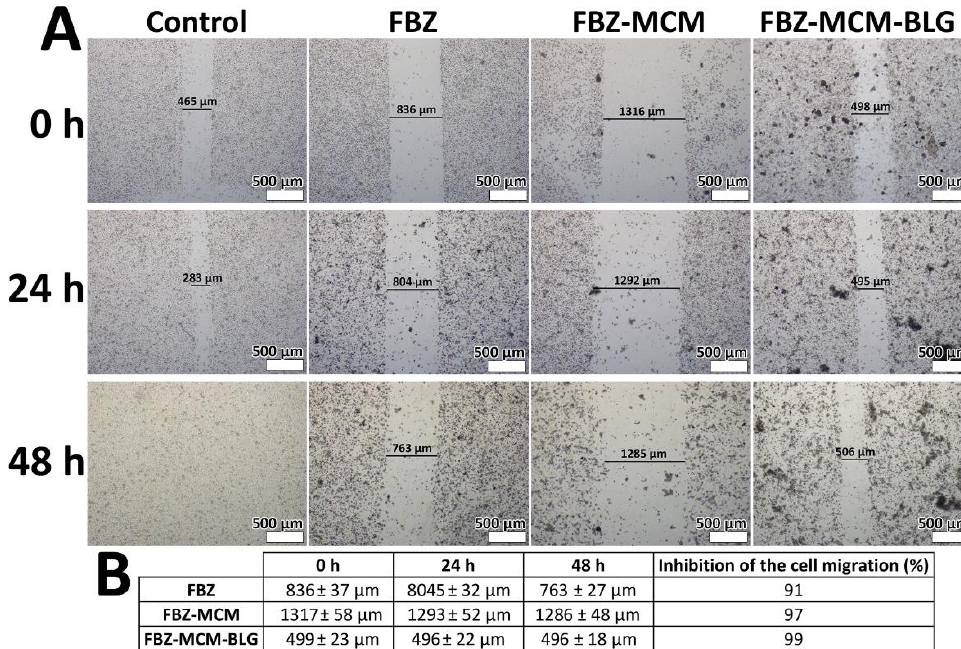
Figure 7. ( A , B ) Effects of FBZ, FBZ-MCM, and FBZ-MCM-BLG nanoparticles on the migration and invasion of prostate cancer PC-3 cells before (0 h), 24 h after, and 48 h after cell treatment (×40 mag). Compared to the control group, FBZ, FBZ-MCM, and FBZ-MCM-BLG restrained cell migration, confirming the efficacy of FBZ, FBZ-MCM, and FBZ-MCM-BLG in inhibiting prostate cancer cell metastasis and invasion.